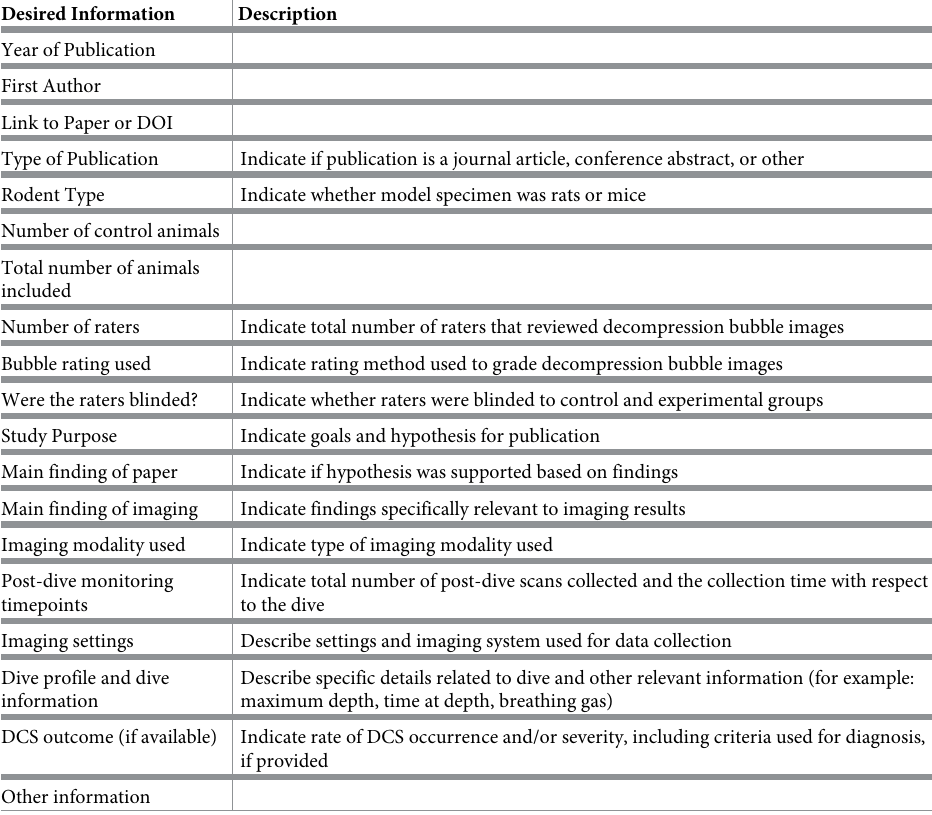
Table 5. Data extraction template. Selected information to be extracted from each accepted paper during review